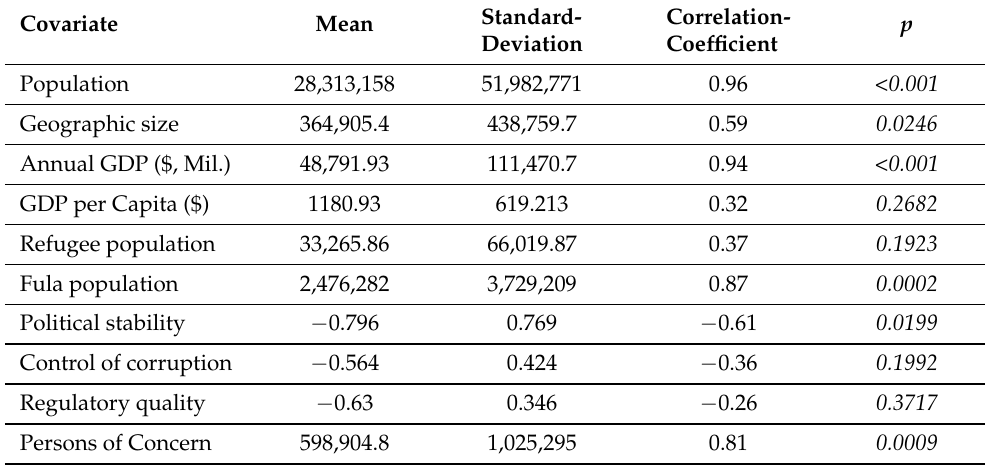
Table 6. Covariates chosen through the backward selection for the linear multiple regression.